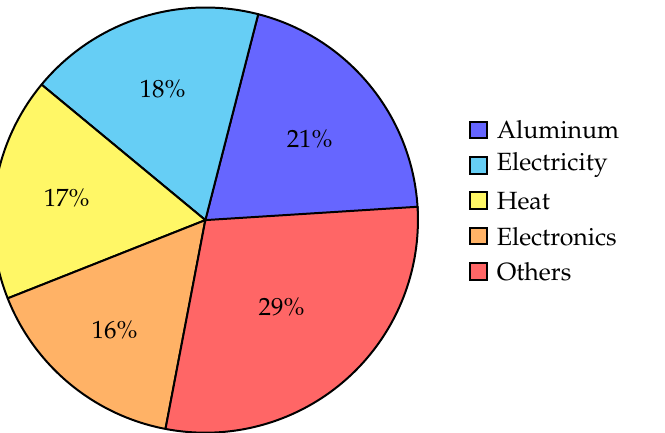
Figure A4. The contributions of the various components toward the emissions of the battery system.